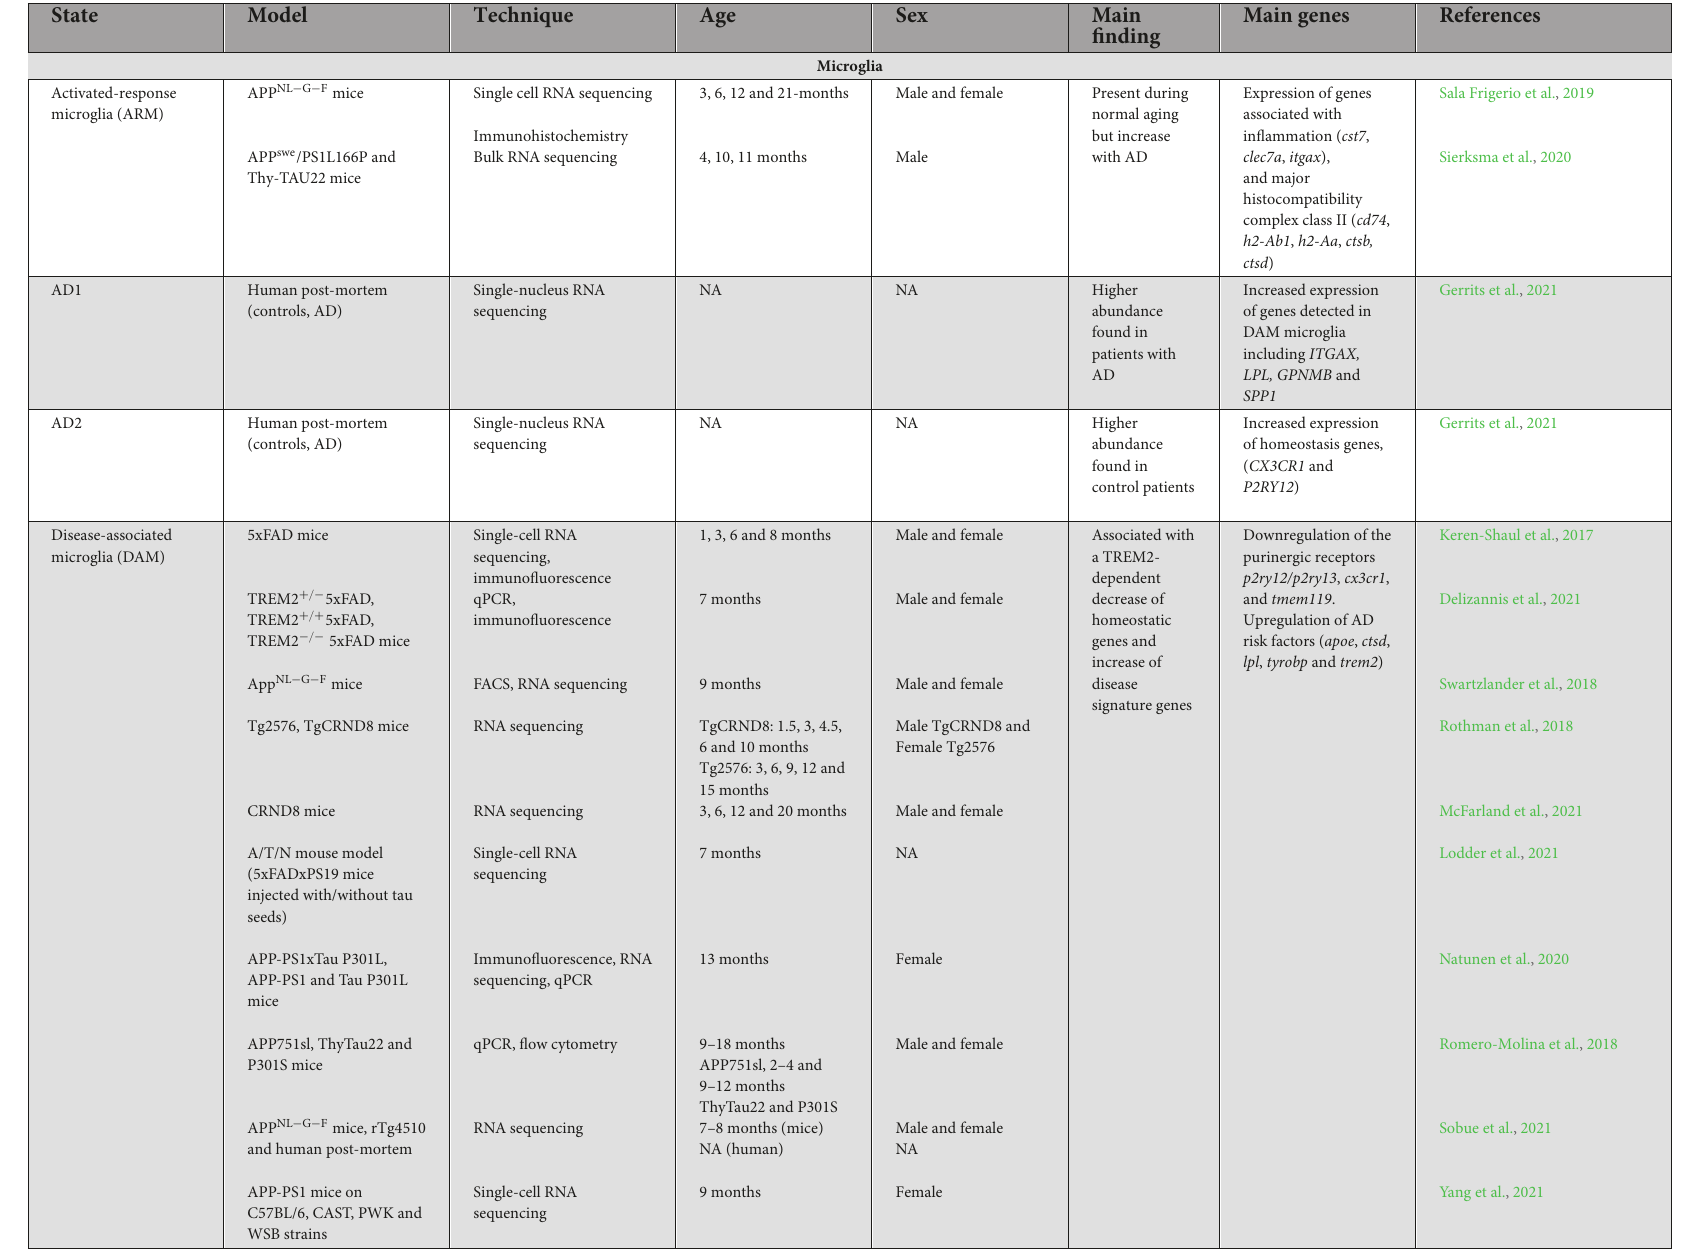
TABLE 2 Summary of microglial and astrocytic states observed in mouse models of AD pathology and human post-mortem brains of patients with